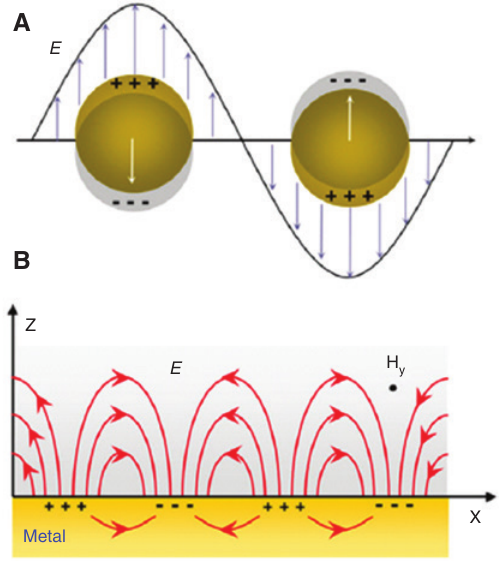
Figure 1: Sketches of the mechanism of LSPs, PSPs. (A) LSPs are collective oscillation of free electrons confined on the surface of metal nanoparticles and (B) PSPs are excitation of collective electrons that can only propagate near the vicinity of the interface